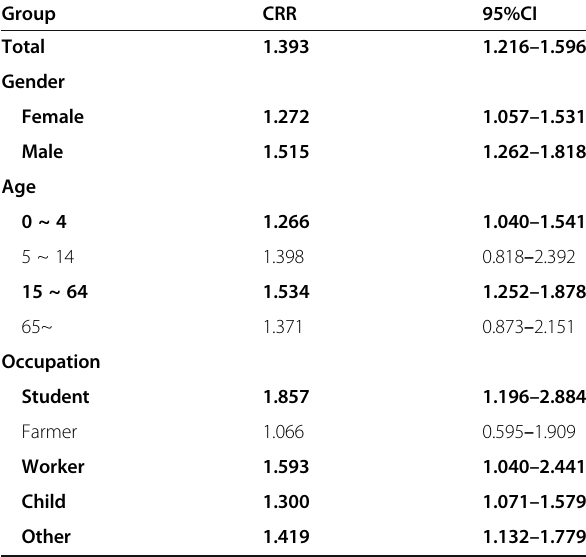
Table 2 Cumulative relative risk based on 7-lag